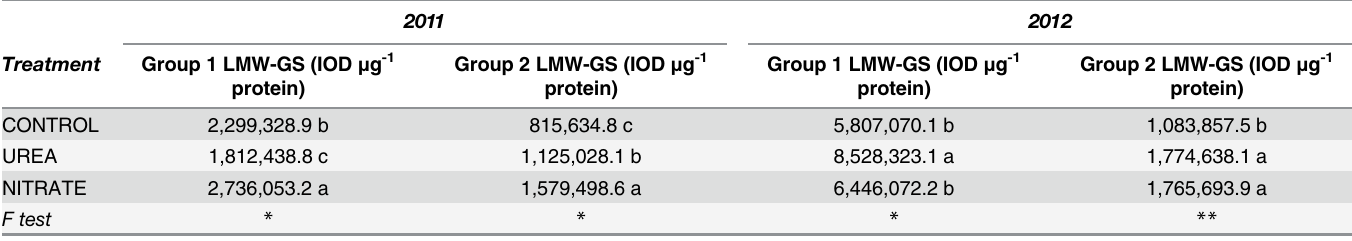
Table 3. Quantitative densitometry analysis of LMW-GS from Group 1 and Group 2 extracted from wheat grains deriving from plants exposed to control conditions (unfertilized CONTROL) and to two fertilization treatments with Urea (UREA) and Calcium Nitrate (NITRATE) at the rate of 150 kg N ha -1